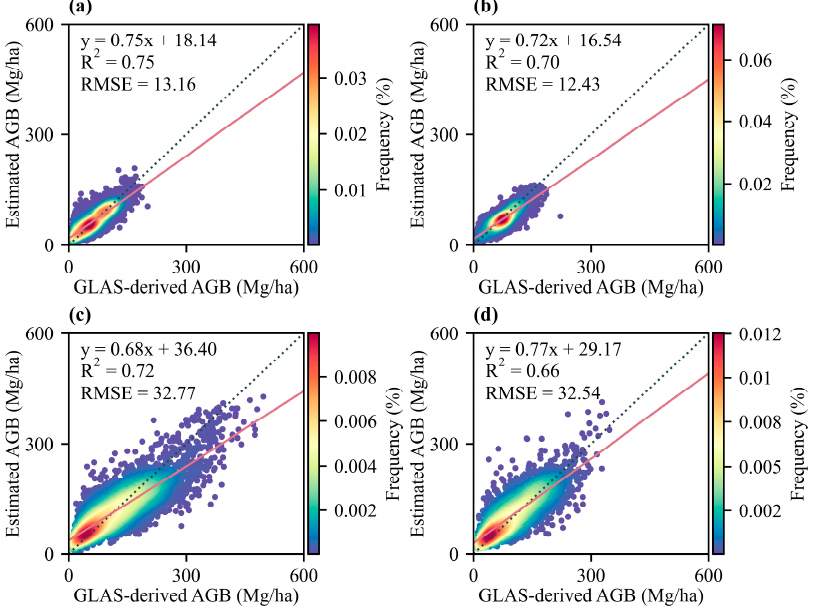
Figure 3. Performance of the Stacked model in the cross-validation for different forest types in different geographical regions. The dotted lines and red lines are 1:1 line and fitting line, respectively. ( a ) Broadleaf in region N, ( b ) conifer in region N, ( c ) broadleaf in region S, and ( d ) conifer in region S.